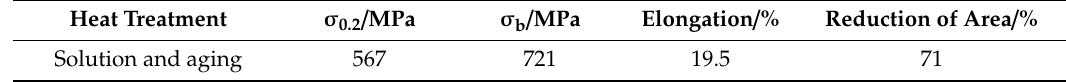
Table 2. The mechanical properties of TLM titanium alloy.